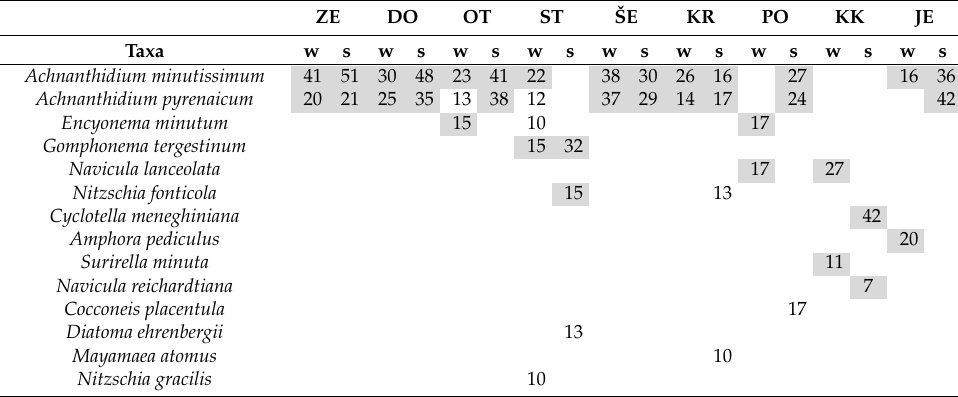
Table 3. Dominance of taxa in winter (w) and summer (s) samples. The proportions of the two most abundant taxa are in shaded cells. Other species are considered co-dominant because their proportion is > 10%. For full names of the sampling sites and their locations along the river Sava see Figure 1.